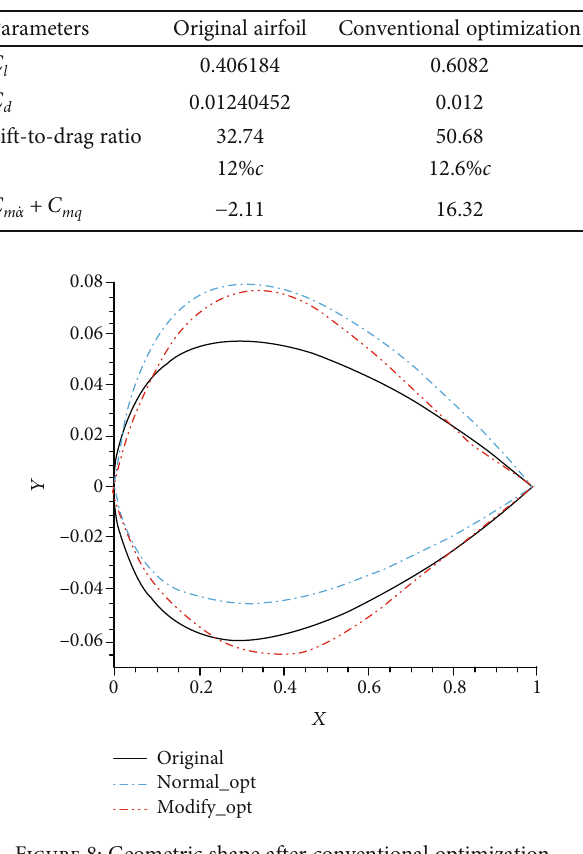
Figure 8: Geometric shape after conventional